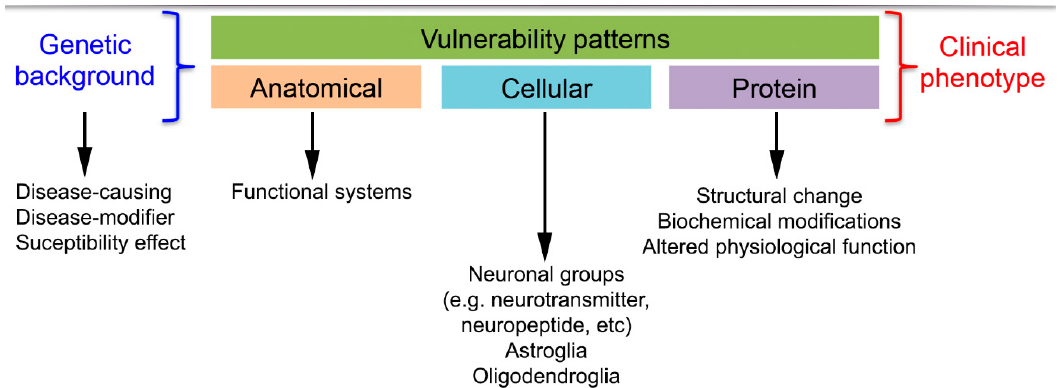
Figure 1. Summary of the concept of vulnerability patterns in neurodegenerative diseases. Coloured boxes represent different vulnerability patterns.